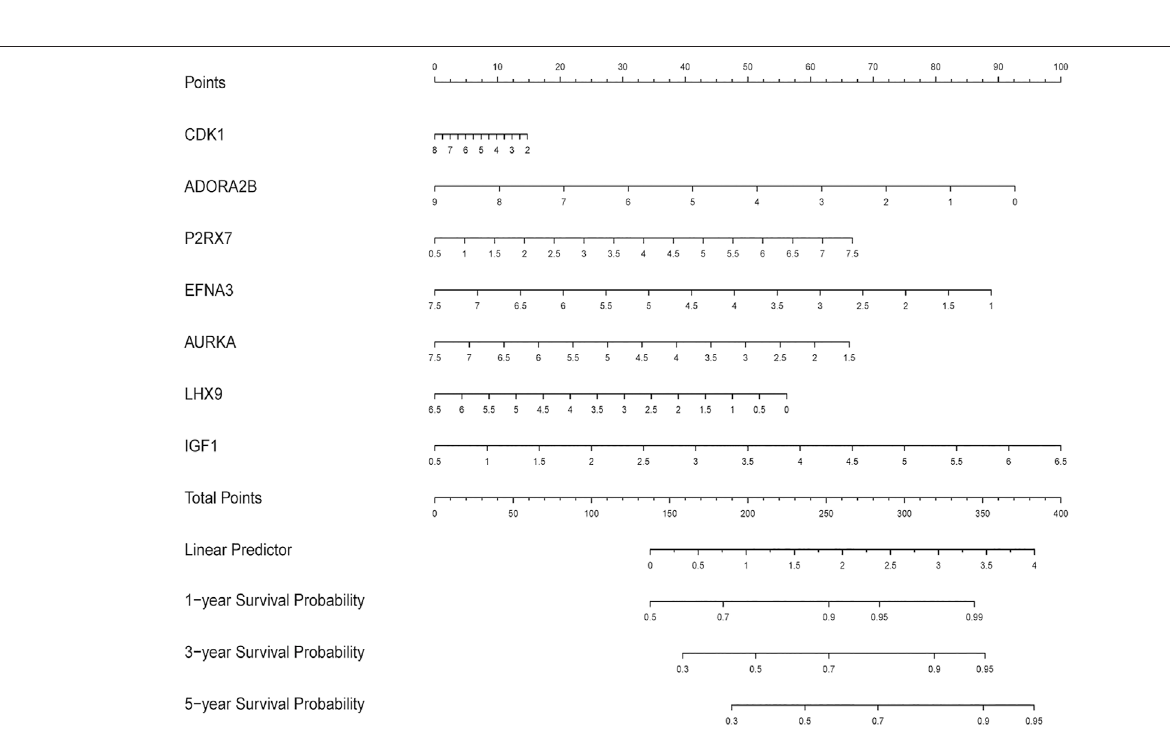
Frontiers in Genetics |